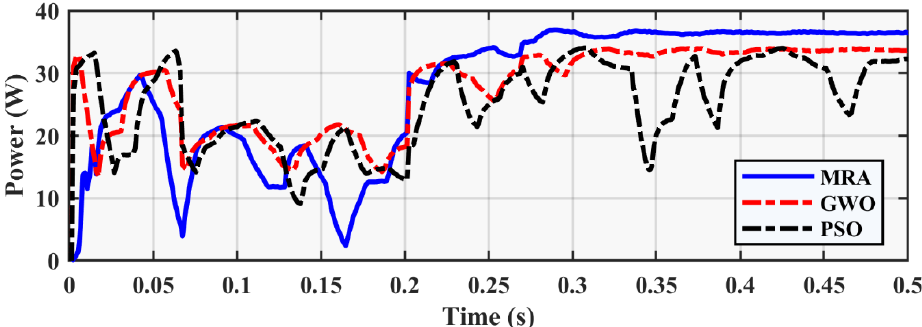
Figure 15. PSO, GWO, and MRA hardware results.